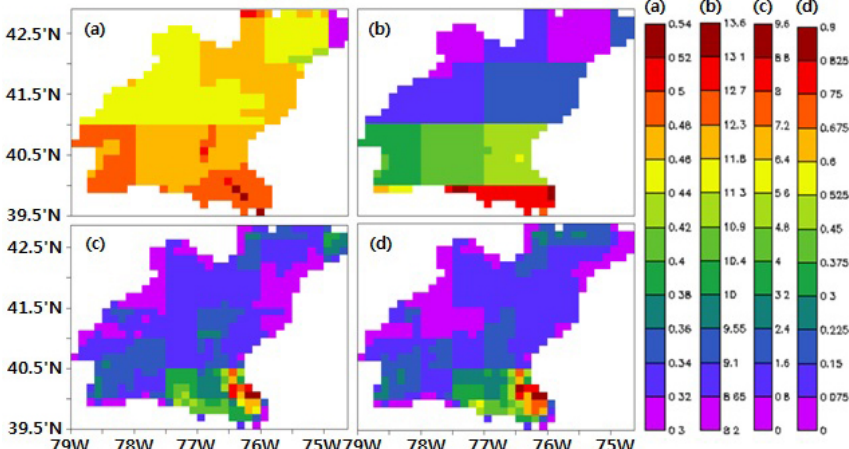
Figure 8. Spatial distribution maps of 20year average (1986–2005) (a) soil water content, (b) temperature ( ◦ C), (c) nitrate N content (10 2 × kgm − 2 ), and (d) denitrification rate (10 2 × kgm − 2 year − 1